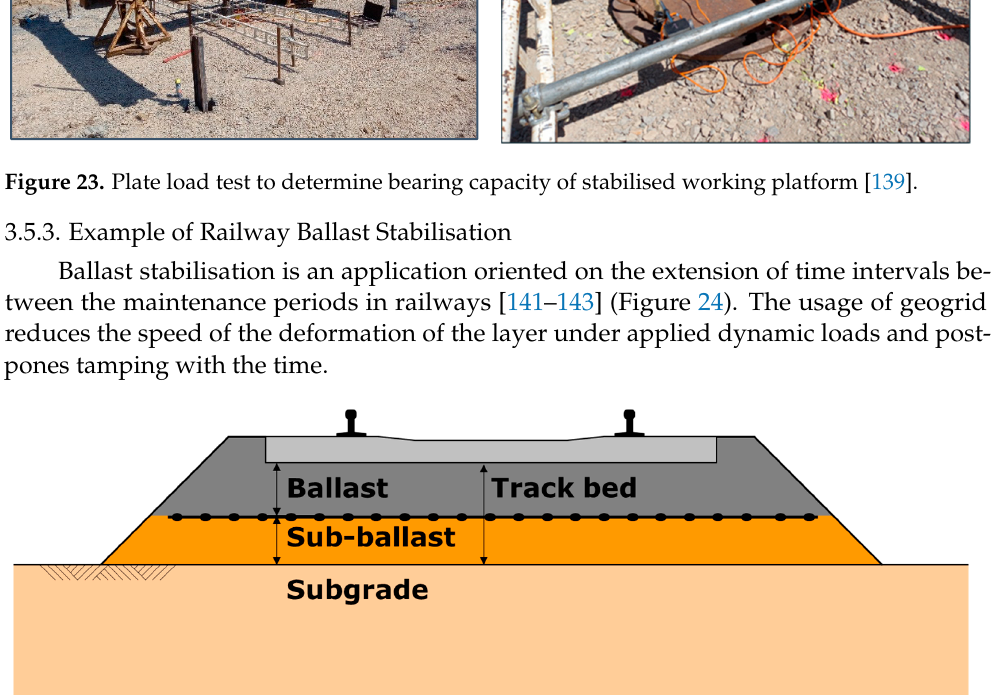
Figure 23. Plate load test to determine bearing capacity of stabilised working platform [139].